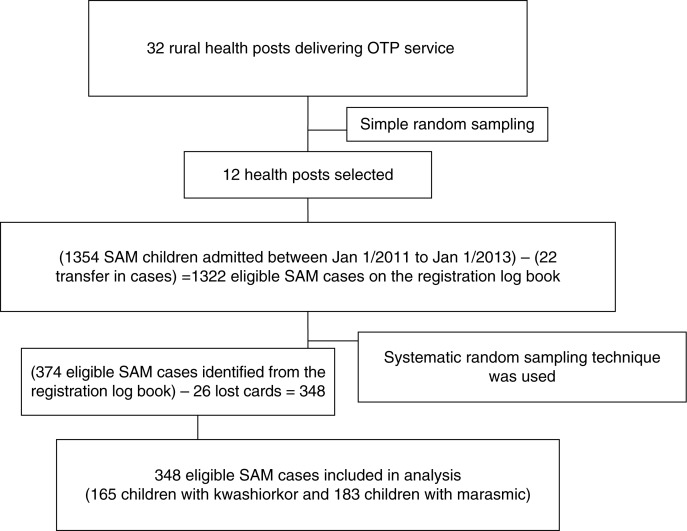
Sampling scheme of severe acutely malnourished children included in the study. Simple random sampling was used to select health posts. In the selected health posts, systematic random sampling was used to select eligible SAM children. SAM refers to Severe Acute Malnutrition and OTP refers to Outpatient Therapeutic Care Program.